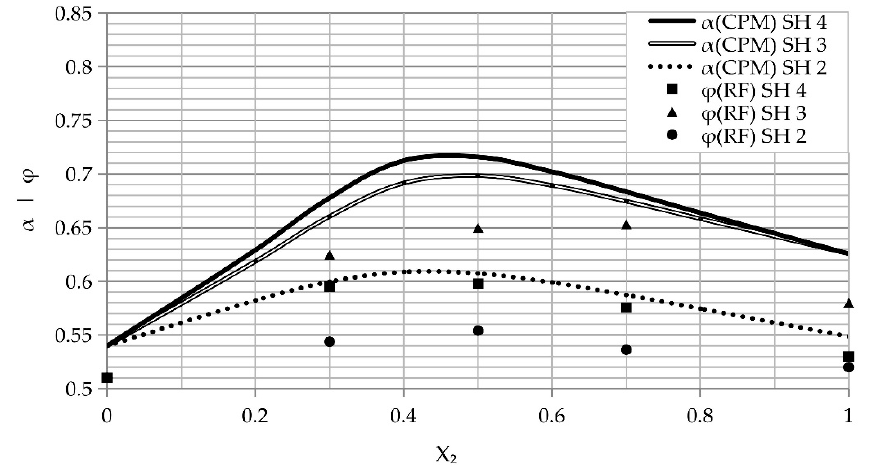
Figure 6. The curves of the porosity ( φ ) and an actual packing density of the double fracture packing ( α ) as a function of the second fracture (X 2 ) content for different sizes of granules are shown. RF—replicated foam, CPM—compaction packing model (De Larrard model).